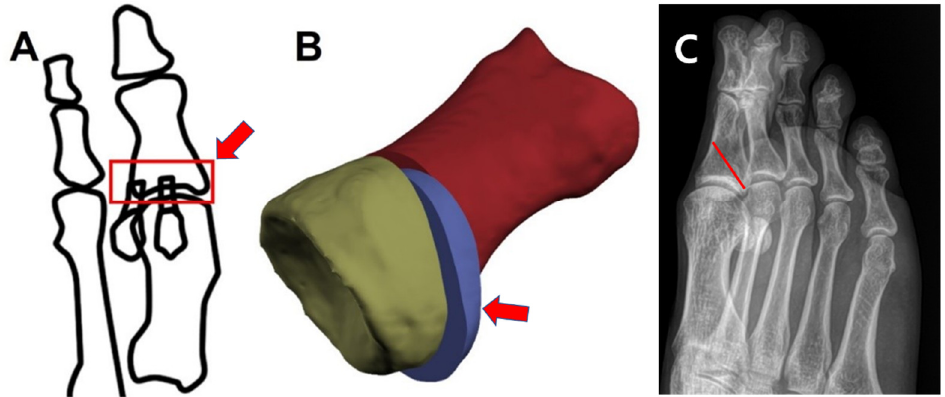
Figure 1. Schematic drawing of the modified proximal phalanx osteotomy. ( A ) The red rectangle shows the insertion of the flexor hallucis brevis, which is rotated for the reduction of sesamoids in an MPO; ( B ) Closed wedge osteotomy can be done; ( C ) Oblique cutting line can be visualized in the foot oblique radiograph.